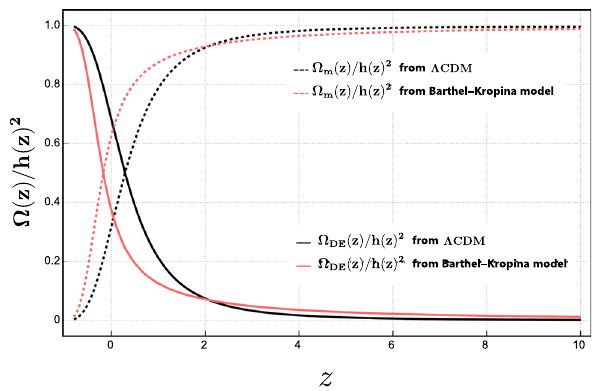
Fig. 11 The reduced matter density parameters as a function of the redshift z in the Barthel–Kropina and (cid:2) CDM cosmological